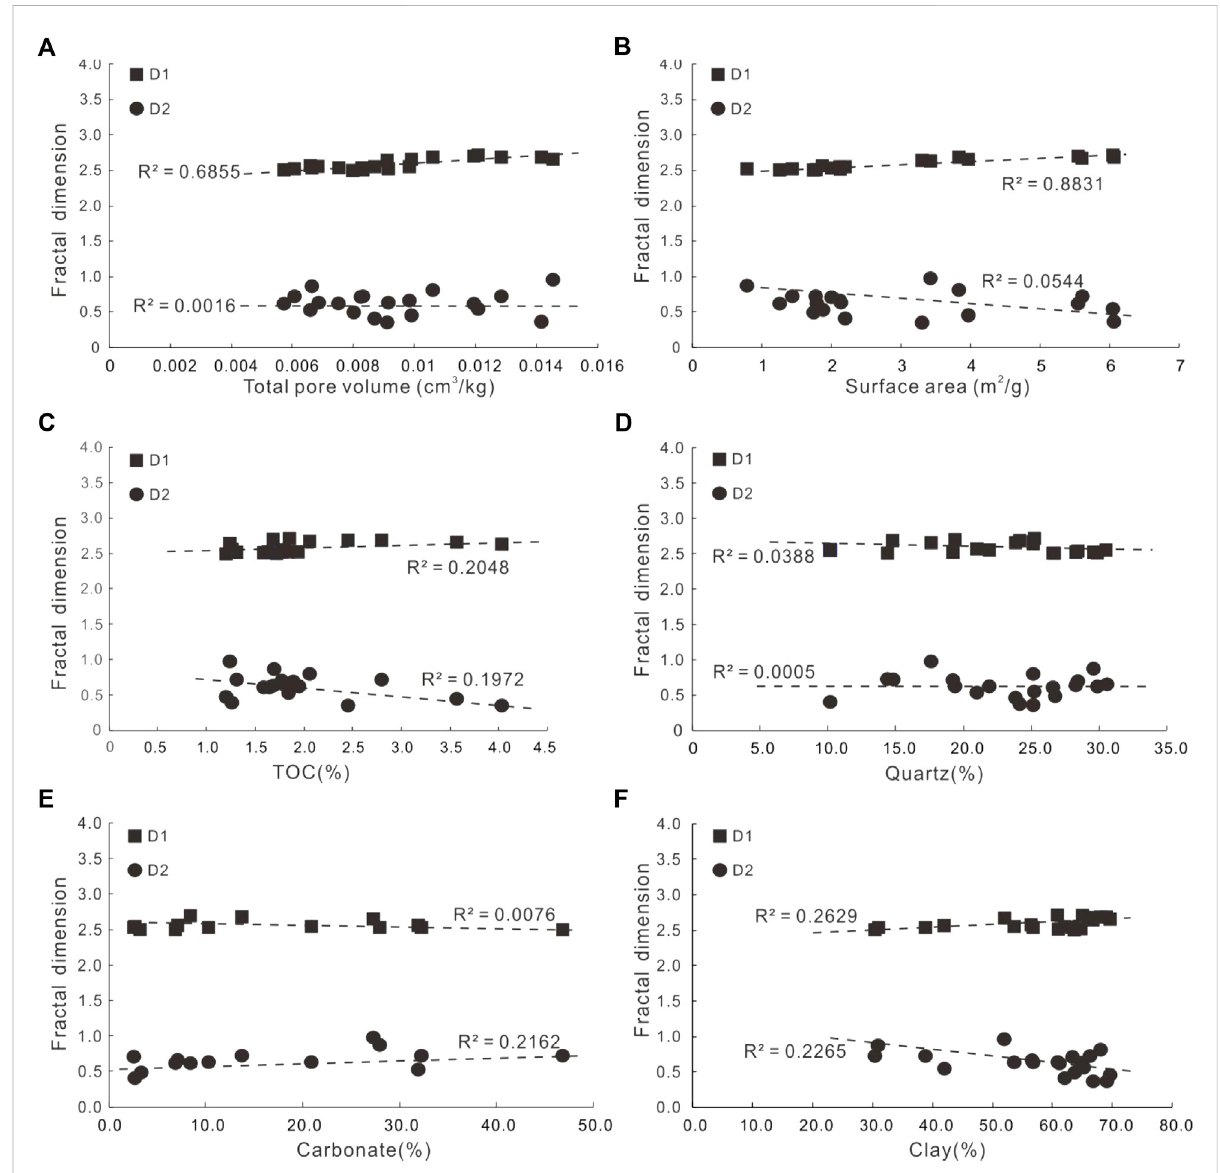
FIGURE 9 Correlations between fractal dimensions, total pore volume, surface area, TOC, quartz content, carbonate content and clay content for the Jurassic Dongyuemiao lacustrine shale in Eastern Sichuan Basin.